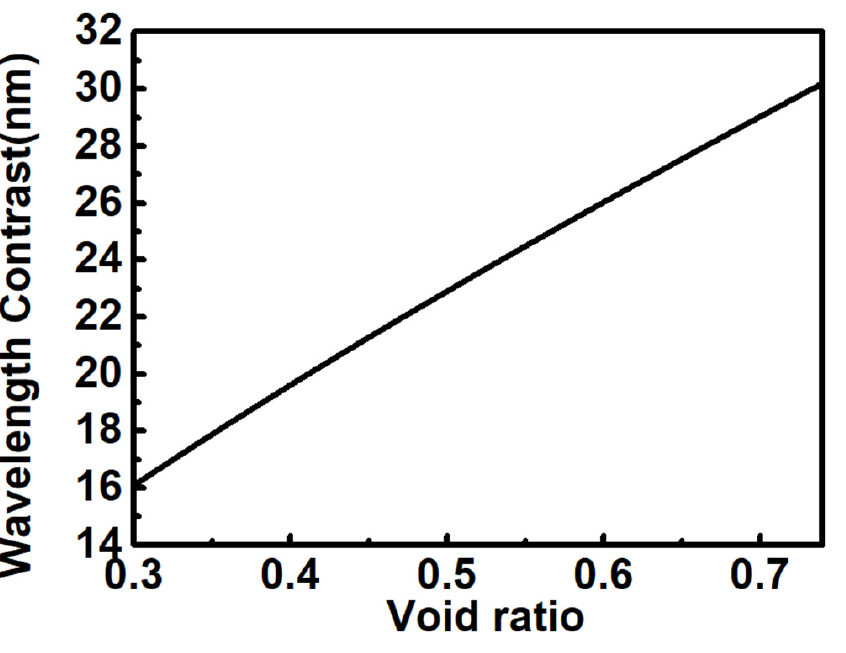
Figure 5. The relationship between wavelength range contrast ( ∆ λ PEGDA-contrast ) and void ratio ( D ) of the system.